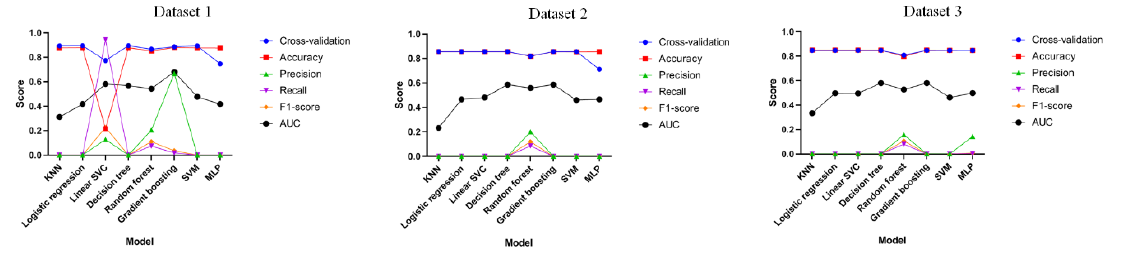
Figure 4. Performance evaluation results of cross-validation, accuracy, precision, recall, f1-score, and AUC according to Datasets 1 to 3.